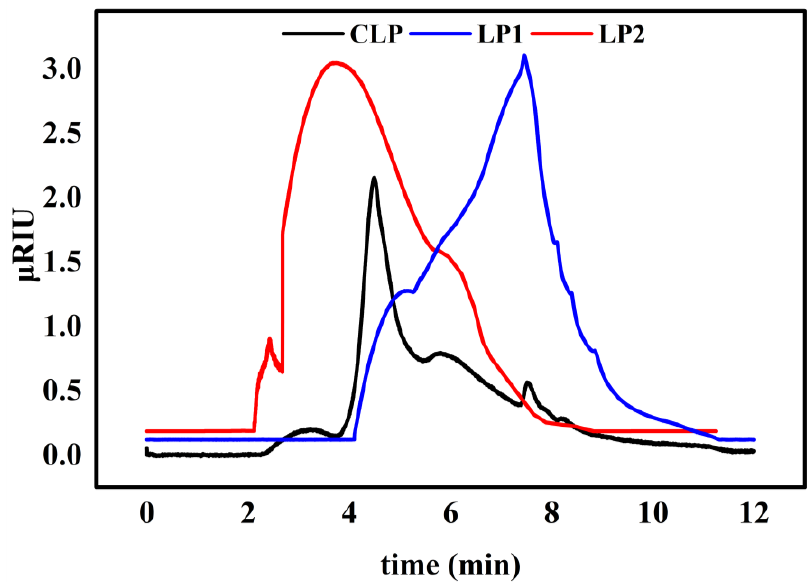
Figure 1. Chromatograms of the molecular weights of CLP, LP1, and LP2. Table 1. Basic characterization of LP1 and LP2.